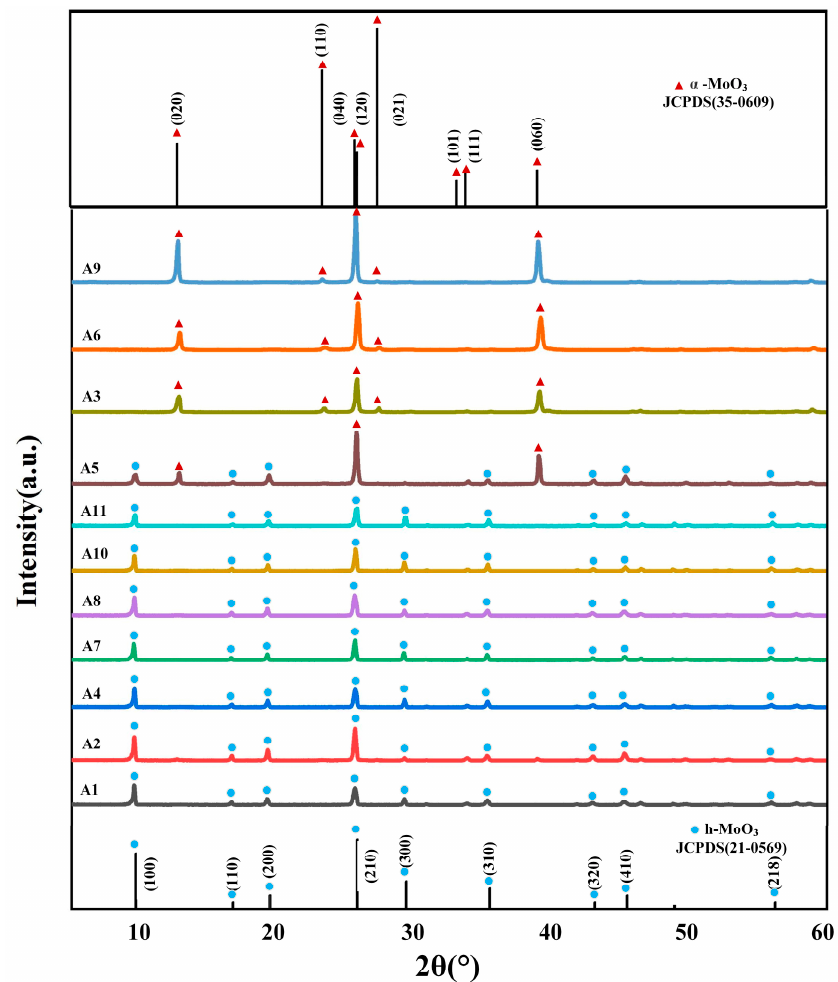
Figure 1. XRD patterns of samples A1–A11. Figure 1. XRD pa tt erns of samples A1–A11. Figure 1. XRD pa tt erns of samples A1–A11.